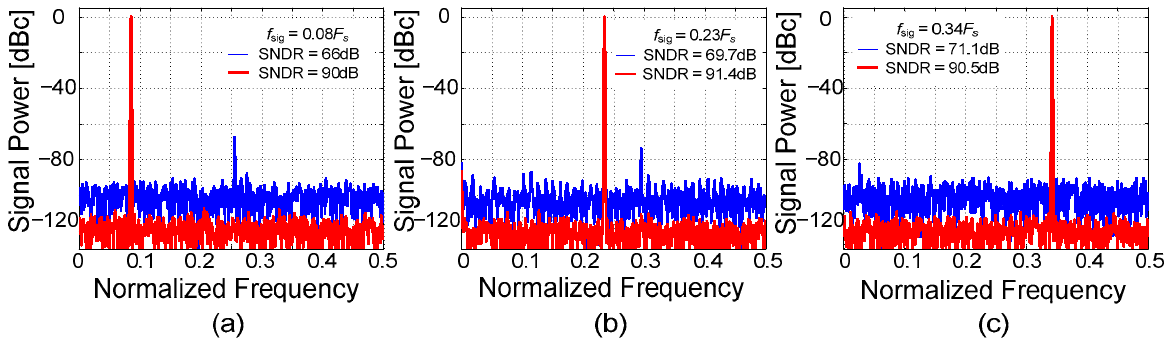
Figure 12. Simulated output spectrum when input signal frequencies are ( a ) f sig = 0.08 F S ; ( b ) f sig = 0.23 F S , and ( c ) f sig = 0.34 F S .